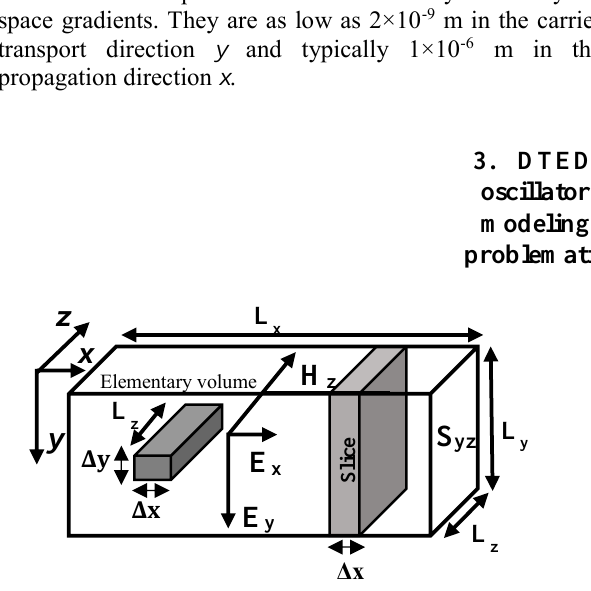
Figure 2: DTED oscillator geometrical parameters The simplest DTED semiconductor structure is a microstrip propagation line. Accounting for its geometrical dimensions, its numerical modeling on its own in 3D is still out of capacity of our calculation